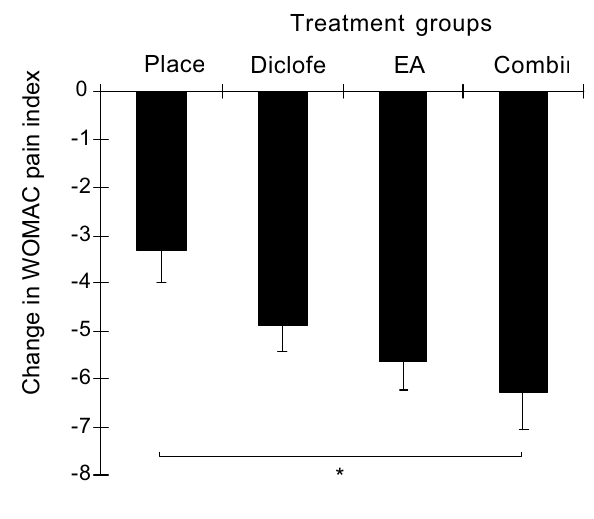
Figure 4 Change in WOMAC pain index in each treatment group evaluated at the end of week 4. Values are mean ± SEM. * = p < 0.05 between groups (one-way ANOVA and Scheffe